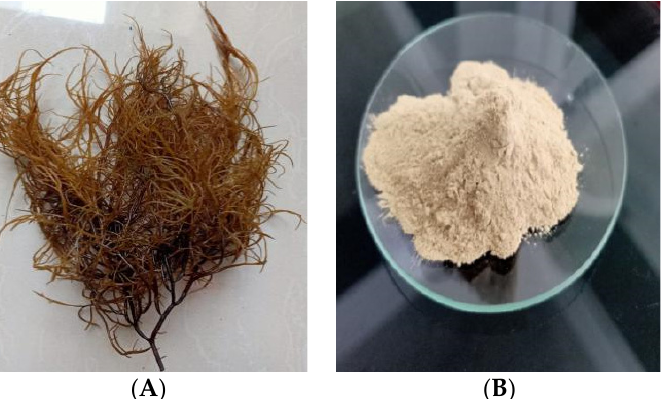
Figure 1. Red seaweed ( Gracilaria verucosa Greville) ( A ) and red seaweed biomass (RSB) ( B ) .